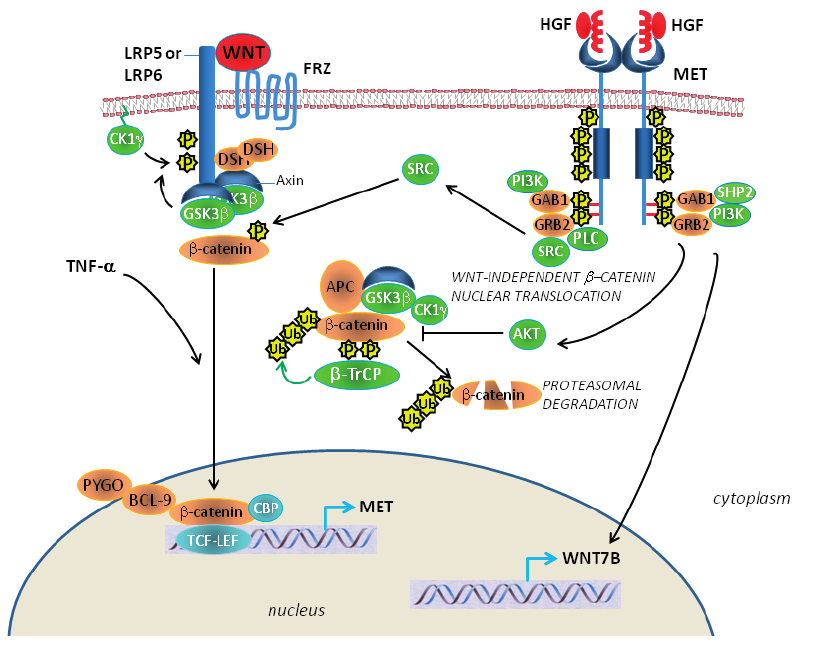
Figure 4. Met and Wnt- β -catenin signaling pathways cooperate in regulating EMT (epithelial-mesenchymal transition). MET contributes to transcriptional activation of Wnt ligands, such as WNT7B. Met contributes to nuclear translocation of β -catenin by its tyrosine phosphorylation (directly or indirectly by SRC), or by inhibition of the β -catenin degradation complex by Akt that phosphorylates glycogen synthase kinase-3 β (GSK3 β ). β -TrCP, β -transducin repeat-containing protein; APC, adenomatous polyposis coli; CBP, CREB-binding protein; CK1, casein kinase 1; DSH, disheveled; FRZ, frizzled; GAB1, GRB2-associated-binding protein 1; GRB2, growth factor receptor-bound protein 2; LRP, low-density lipoprotein receptor-related protein; PLC, phospholipase C; TCF-LEF, β -catenin target genes; TNF- α , Tumor Necrosis Factor- α ; PYGO, pygopus. Modified from [80] with permission of